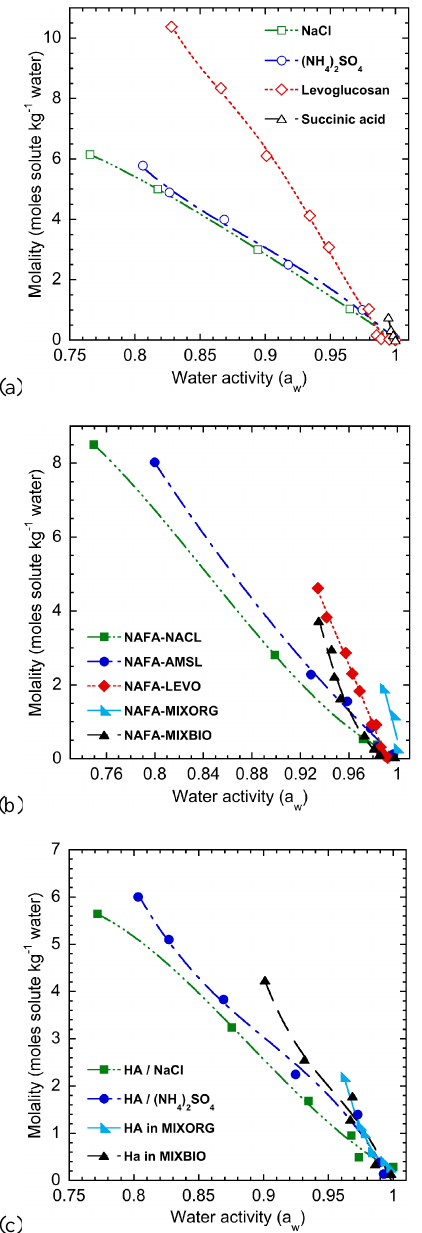
Fig. 3. Water uptake data plotted as molality versus water activ- ity for the (a) pure substances, (b) the NAFA mixtures, and (c) the HA mixtures chosen for this study. Water activity parameterizations were obtained by fitting each data set with a polynomial (lines). Fit coefficients for all solutions are reported in Table 1. Note that the molality was calculated as the ratio of total dissolved moles for all solutes to kilograms of water added to the solution, and that molar weight estimates were used to convert mass of NAFA and HA into moles.